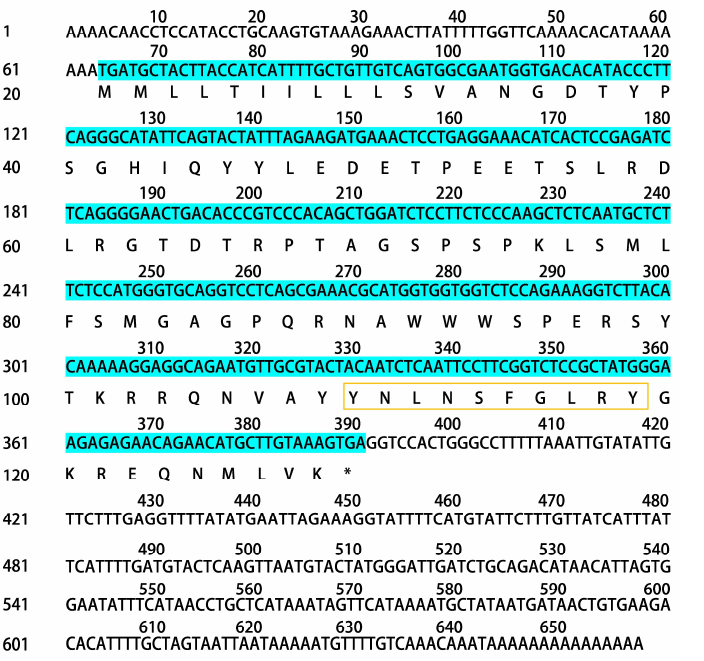
Table 2. Amino acid similarity levels of the kiss1 protein of S. biddulphi with those from other spe- cies.